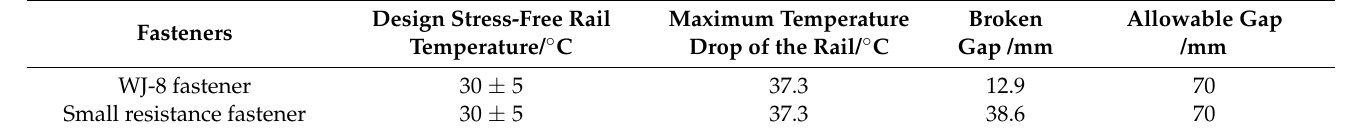
Table 4. Broken gap of the continuous welded rail.